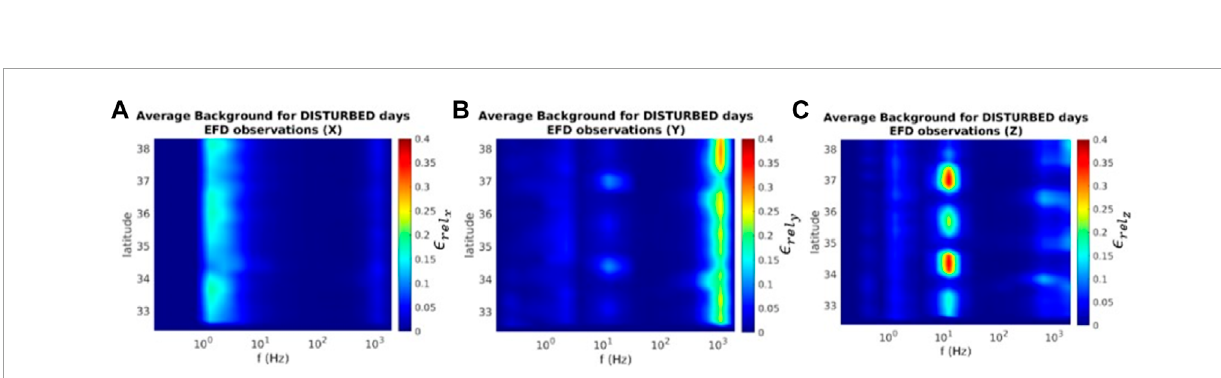
FIGURE 10 Average environmental background for disturbed conditions in a 6°x6° cell over the EE. The ionospheric signals already detected in the first case event can be found again.